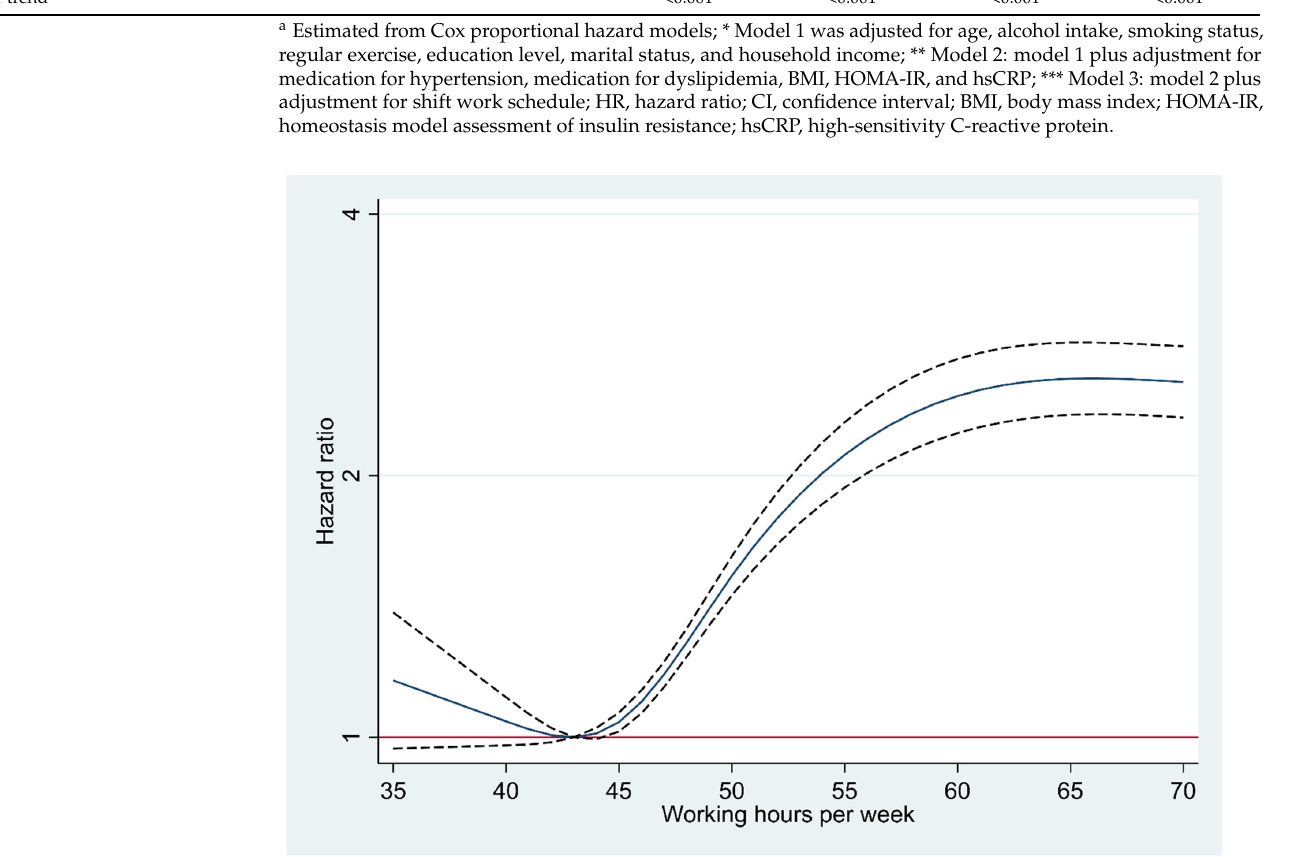
Figure 2. Multivariable-adjusted hazard ratio for glucose intolerance with the restricted cubic spline (70 h; 95th percentile of weekly working hours). Table 3. Hazard ratios a (95% CI) for glucose intolerance by weekly working hours in clinically relevant